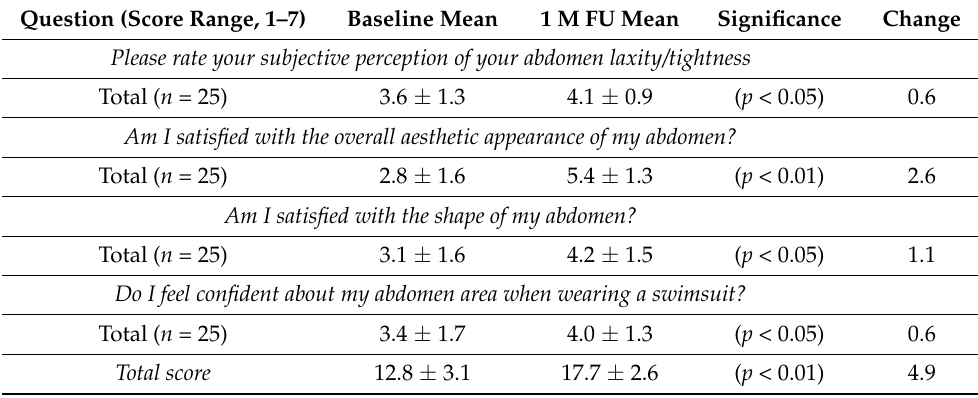
Table 2. Abdomen satisfaction questionnaire